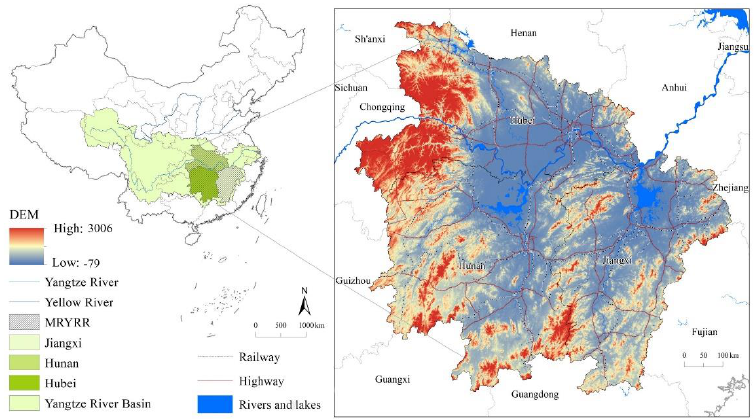
Figure 1. Location of the MRYRR.